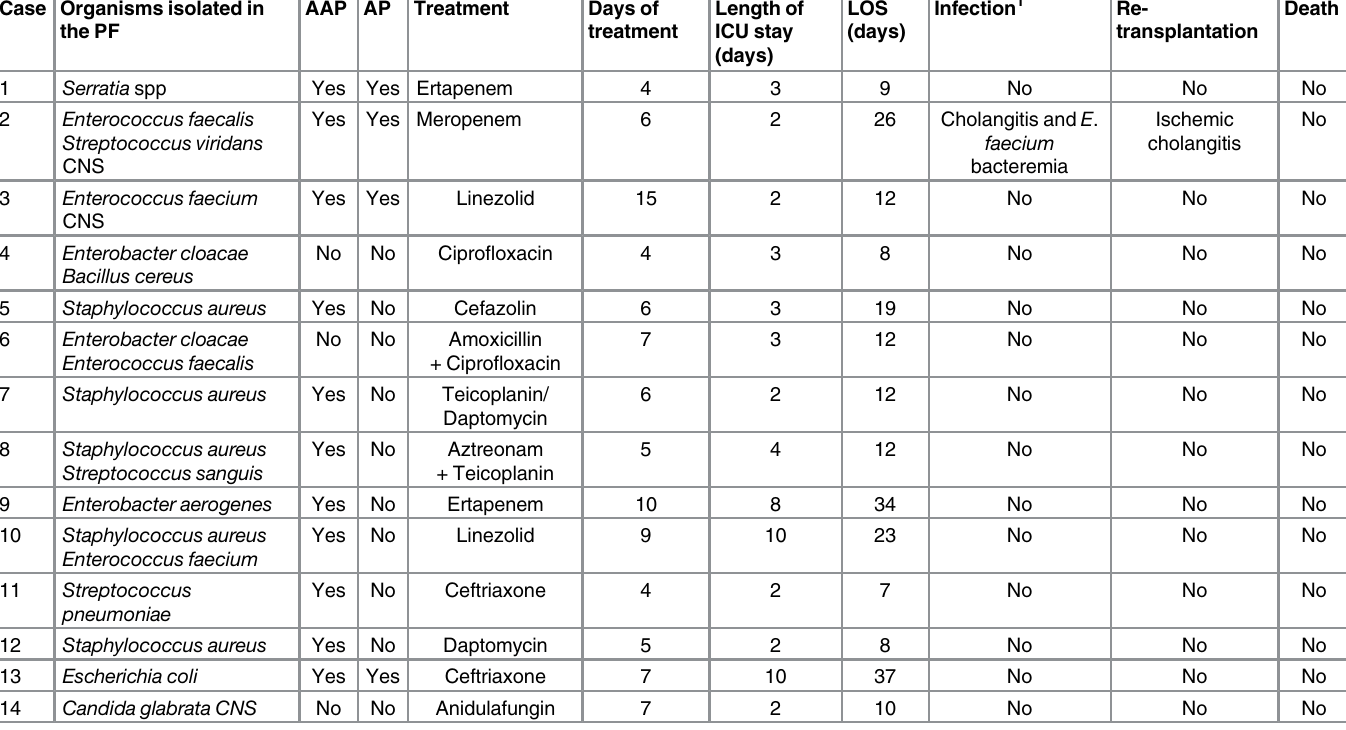
Table 3. Liver recipients with contaminated preservation fluid before implantation: microorganisms involved, susceptibility to antimicrobial pro- phylaxis, treatment and outcomes. Case Organisms isolated in the